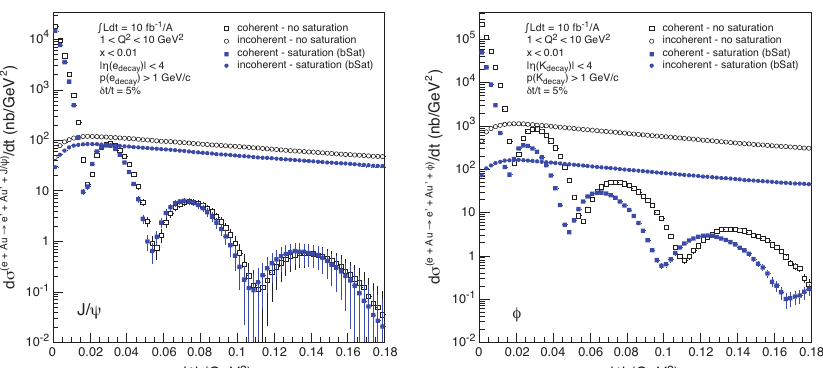
Figure 29. Ratio of diffractive to inclusive DIS cross section in eA normalized to pA (double ratio). Comparison between saturation predictions and the leading twist approach. Figure from the work in [185].